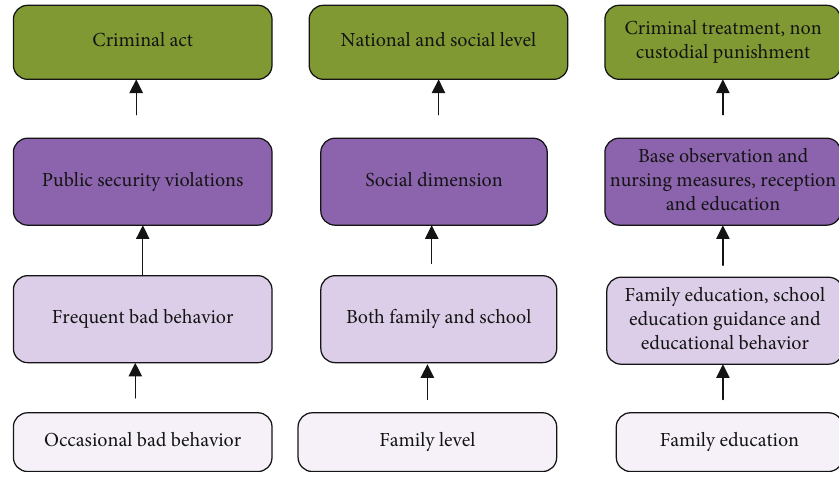
Figure 9: The mixed hierarchical intervention